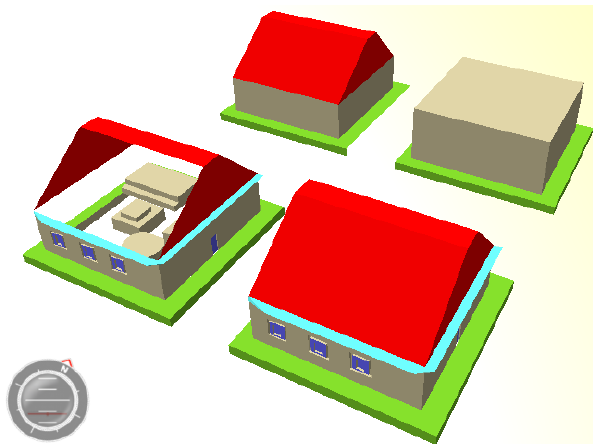
Figure 5. Derived multiple LoDs: LoD4 (bottom-left), LoD3 (bottom- right), LoD2 (top-left) and LoD1 (top-right) visualized in LandXplorer CityGML Viewer